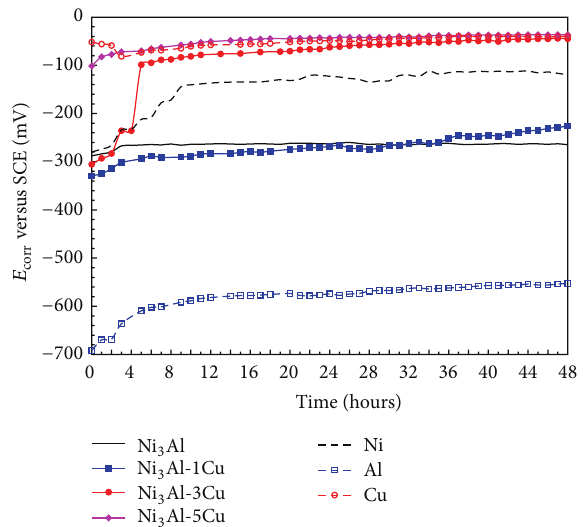
Figure 3: Variation of 𝐸 values for the tested materials in a 1.0M corr H 2 SO 4 solution as a function of exposure